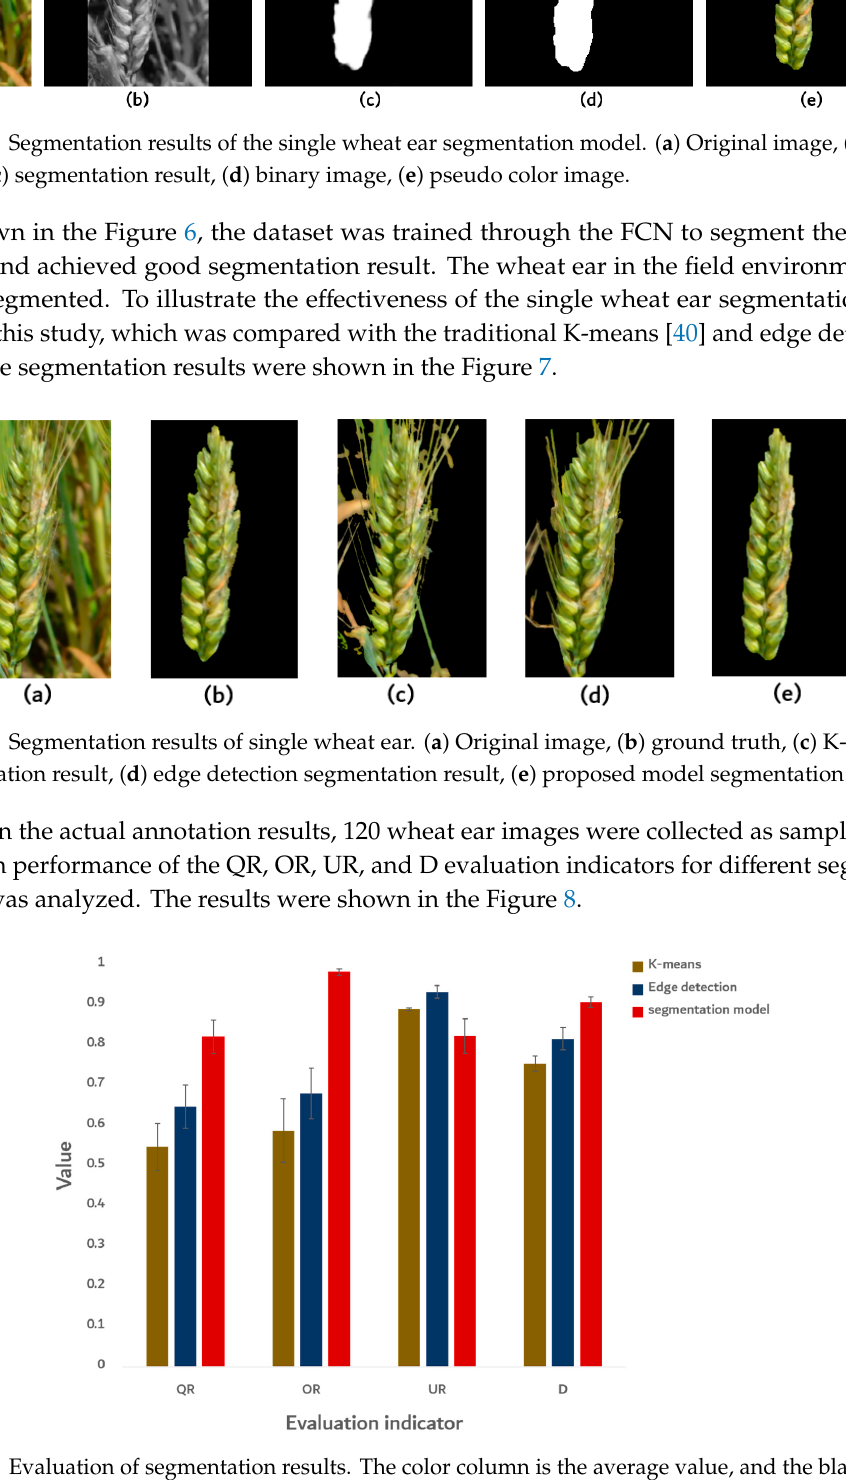
Figure 8. Evaluation of segmentation results. The color column is the average value, and the black line is the error line. Quality rate (QR), over-segmentation rate (OR), under-segmentation rate (UR), and comprehensive measurement rate (D) represent the evaluation indicators of K-means, edge detection, and proposed model,